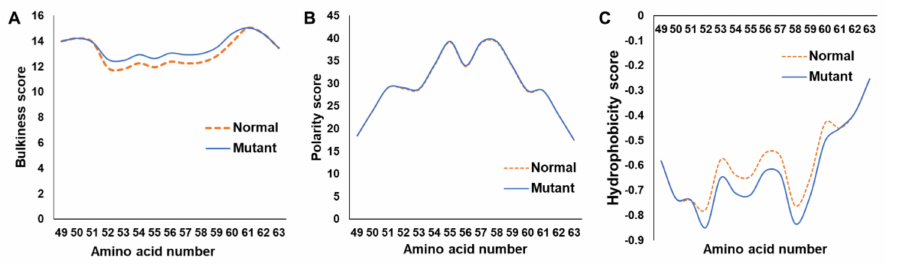
Figure 2. ExPASY scores of wild-type and Gly56Ser PS2. The comparison of protein bulkiness ( A ), polarity ( B ), and hydrophobicity ( C ) scores of wild-type and mutant PS2 via the ExPASY